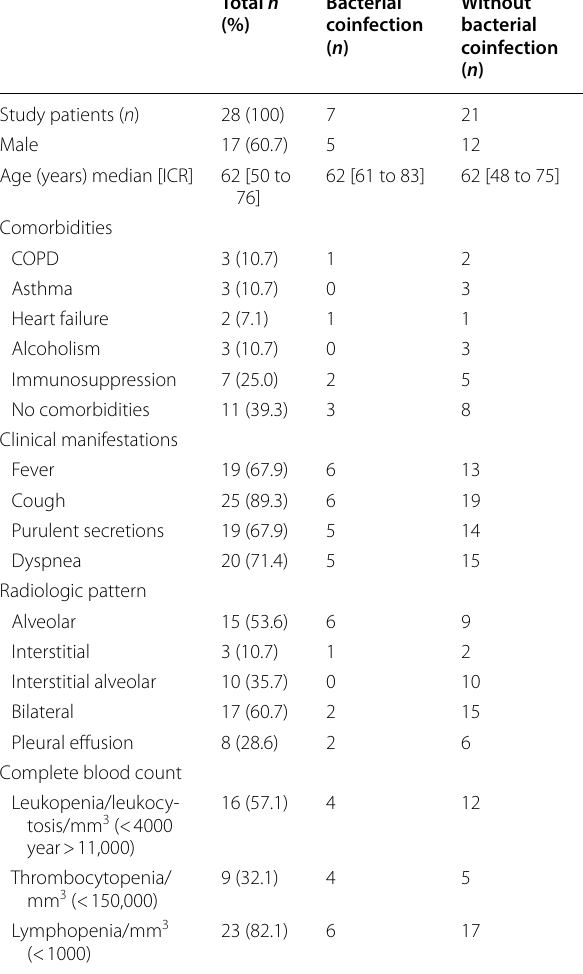
Table 2 Demographic